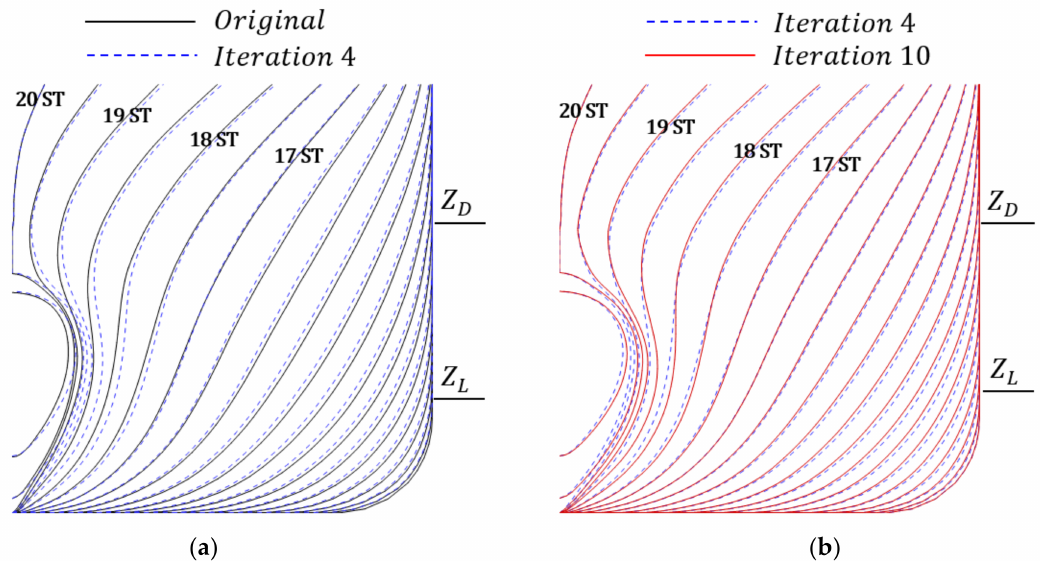
Figure 8. Development of hull form variation during the optimization process. ( a ) Initial optimization period; ( b ) Latter optimization period.